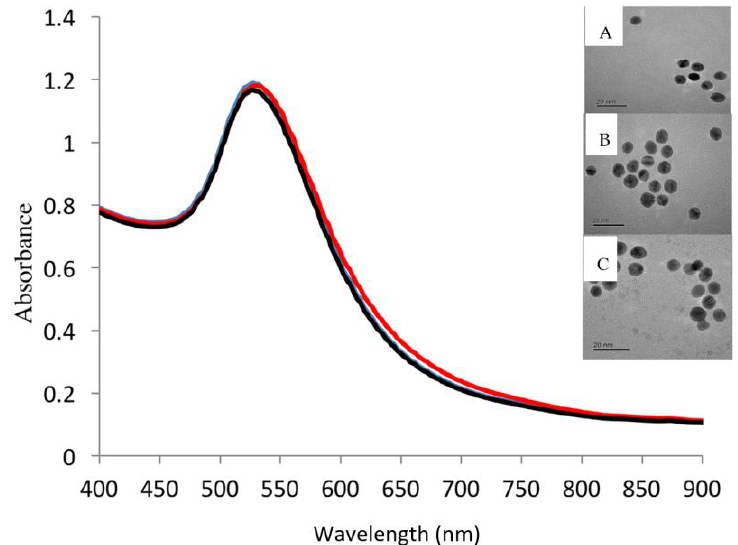
Figure 1. UV-vis absorption spectrum of modified Au NPs. Inset: TEM images (scale bar 20 nm) (black: ( A ) GPDCALNNC-, blue: ( B ) GPG- EN-PEG4-LA-, and red: ( C ) C/G-capped Au NPs).